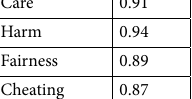
single model from the MFTC fine-tuning stage was selected based on the highest F 1 score, averaged across labels. The F 1 , precision, and recall metrics from tenfold cross-validation are available in Supplementary Materials.